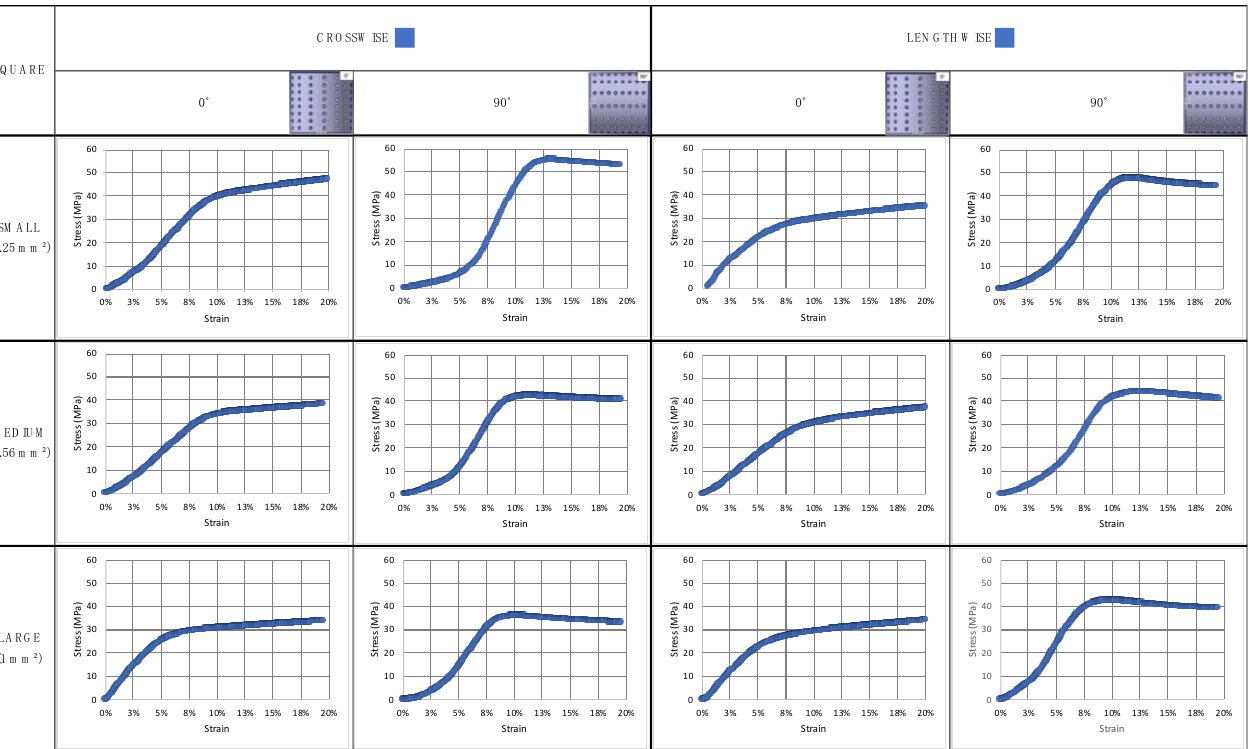
( b ) Figure 5. ( a ) Mean yield strength of square pore scaffolds; ( b ) mean yield strength of circular pore scaffolds. Error bars represent ± standard deviation, n = 5 . Table 3 summarizes every result obtained for square and circular pore shapes, from finite element to experimental testing.